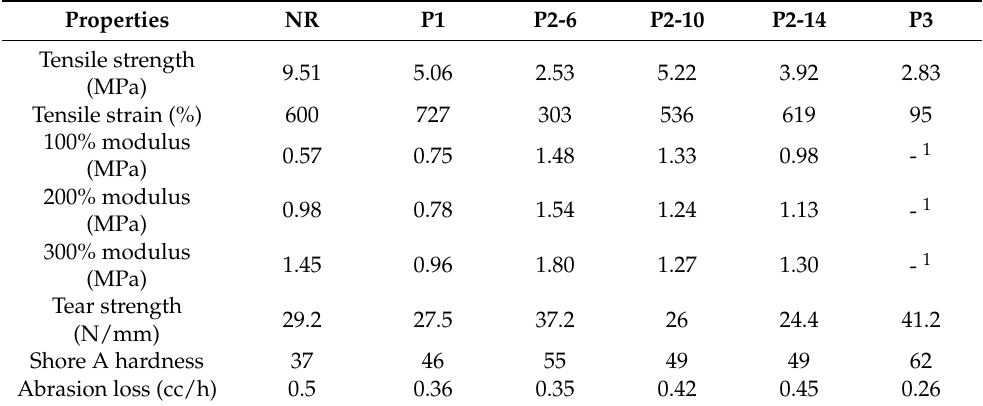
Table 3. Summary of the mechanical results (avg. values) of all rubber matrix composites.